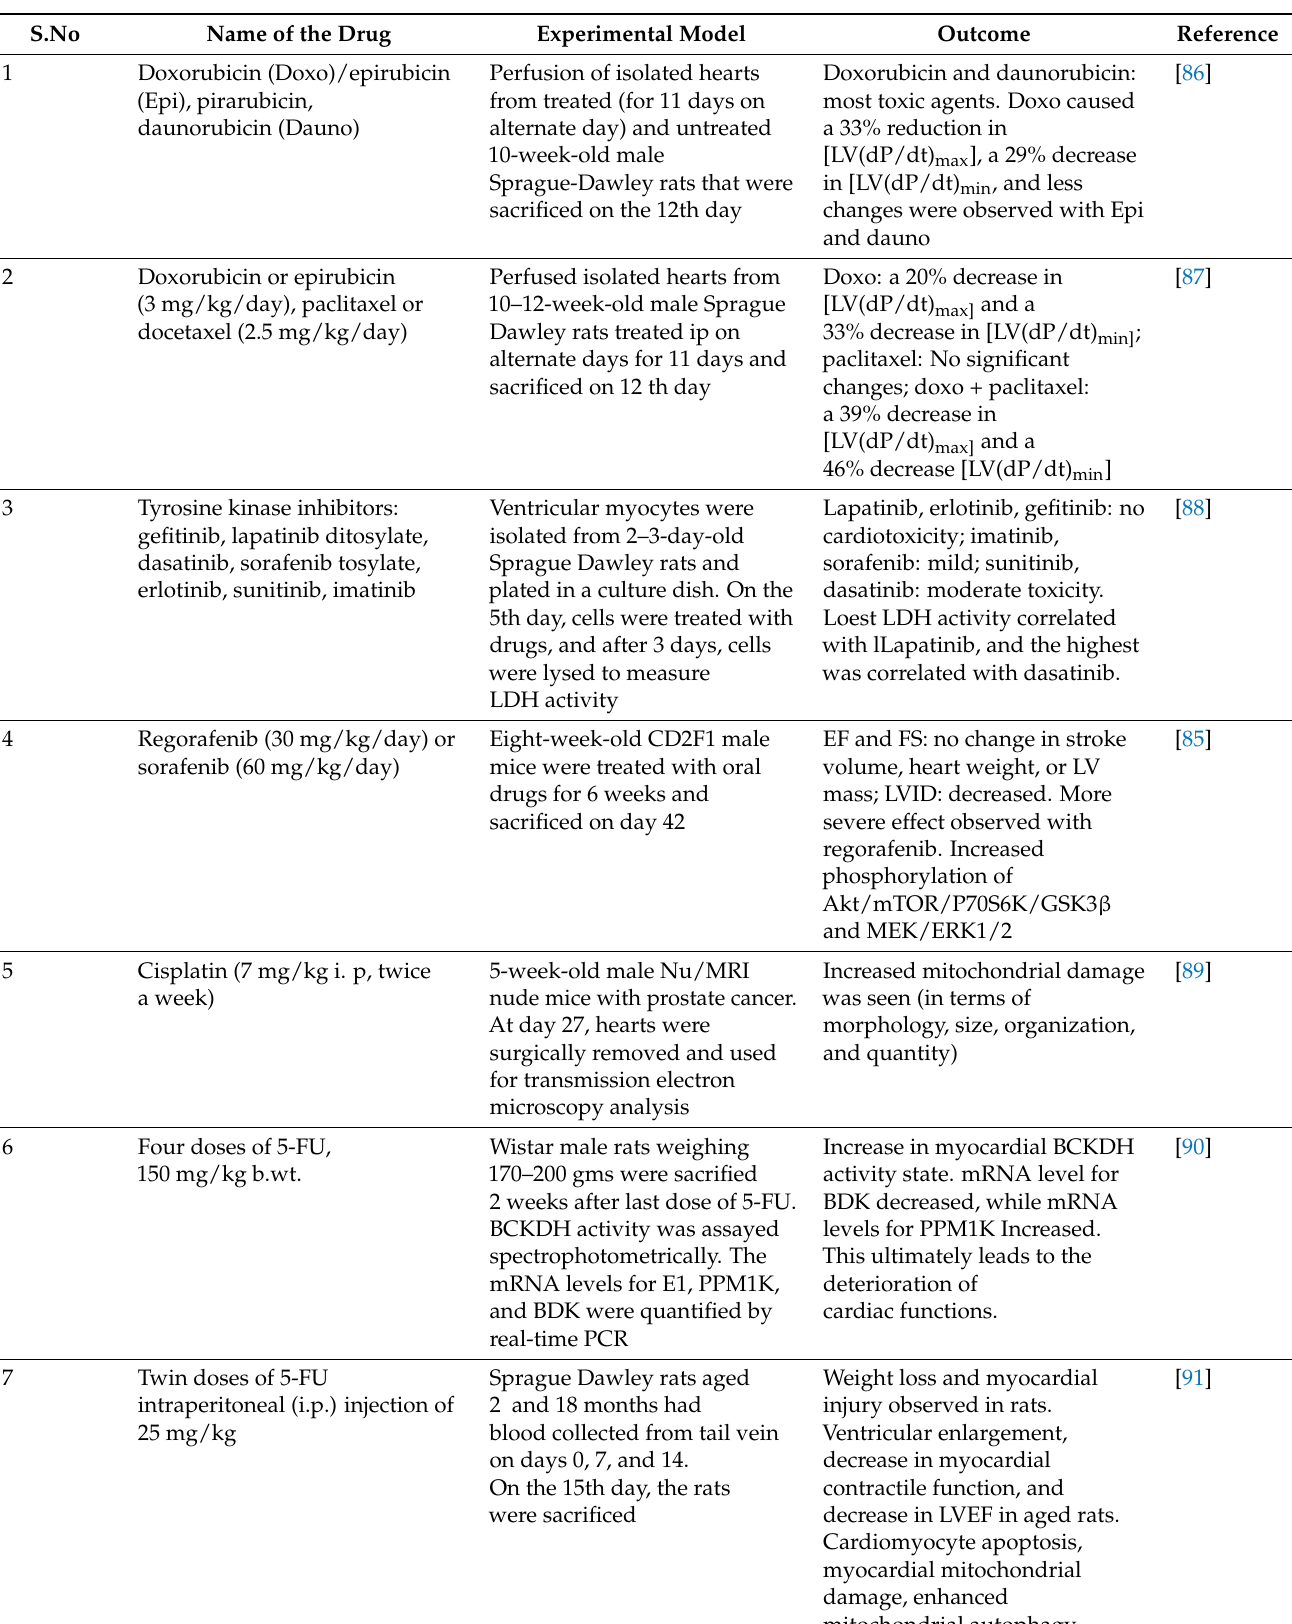
Table 3. Experimental models presenting chemotherapy-mediated cardiac